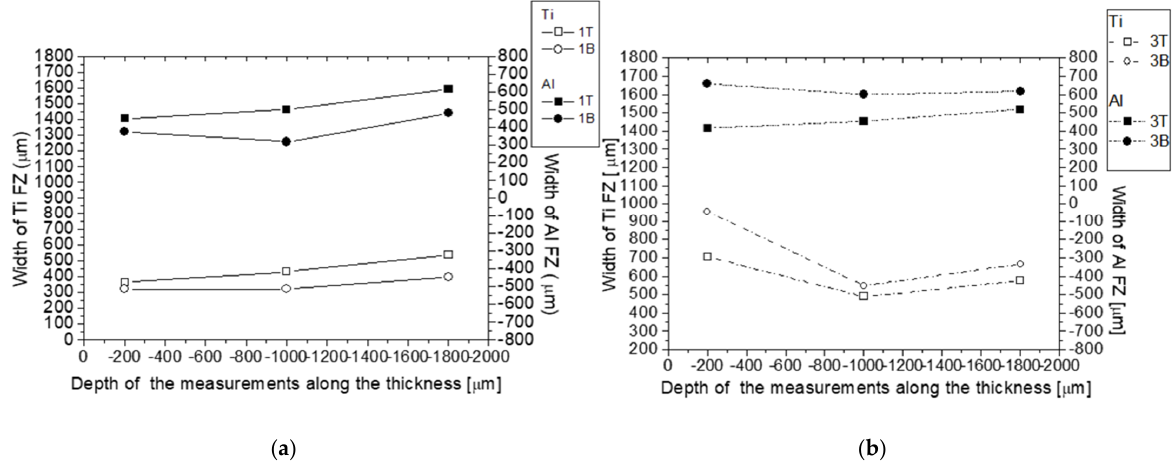
Figure 7. Width of the FZ side along the thickness for joints 1T and 1B ( a ) and joints 3T and 3B ( b ): the size of joint 3B along the thickness is always higher than the size of 3T joint ( b ), while the opposite is true for joints 1T and 1B ( a ).